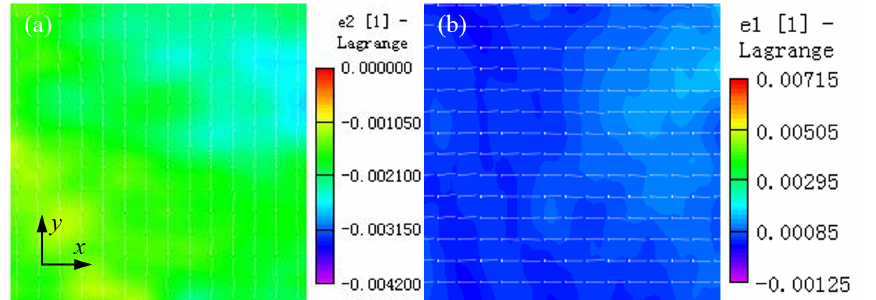
Figure 11. The static strain field that is induced by static stress of y -axis. ( a ) The minimum principal strain field; ( b ) the maximum principal strain field.